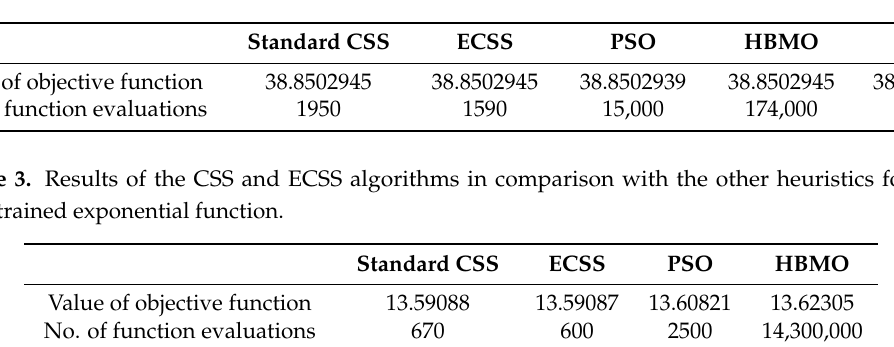
Table 3. Results of the CSS and ECSS algorithms in comparison with the other heuristics for the constrained exponential function.